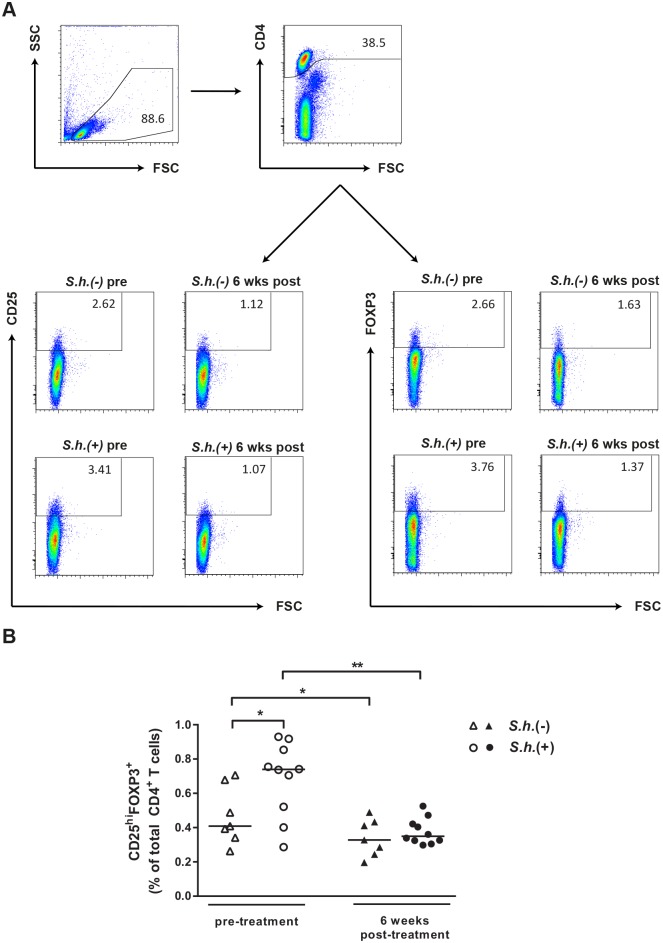
Increased frequency of CD4+CD25hiFOXP3+ Tregs during S. haematobium infection.Gating strategy for identification of CD4+CD25hiFOXP3+ Tregs (A). CD4 T cells were identified and Boolean gating combinations were used to determine proportions of CD4+CD25hiFOXP3+ Tregs (B). Differences between groups were tested with a Mann-Whitney U test and within groups with a Wilcoxon matched pairs test. Horizontal bars represent median. * p< 0.05, ** p< 0.01.